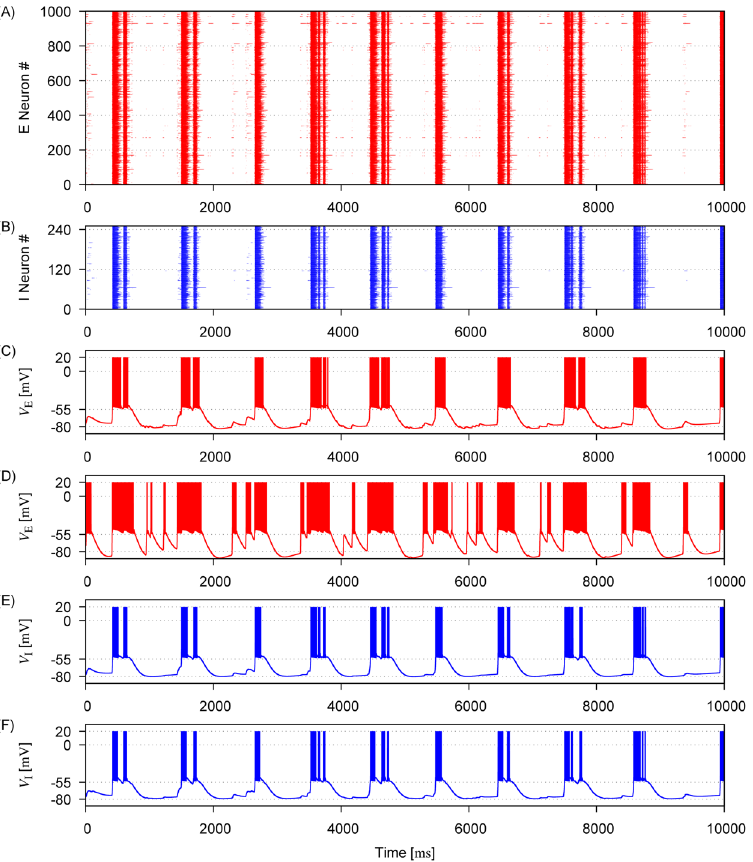
Figure 3. Network activity obtained for a log-normal weight distribution. ( A ) Spike trains of excitatory neurons demonstrate synchronous activity of these neurons. ( B ) Spike trains of inhibitory neurons are shown. ( C , D ) Membrane potentials of two excitatory neurons are displayed as examples. ( E , F ) Membrane potentials are shown for two inhibitory neurons. Parameter values are set as γ E = 0.1 and σ E =